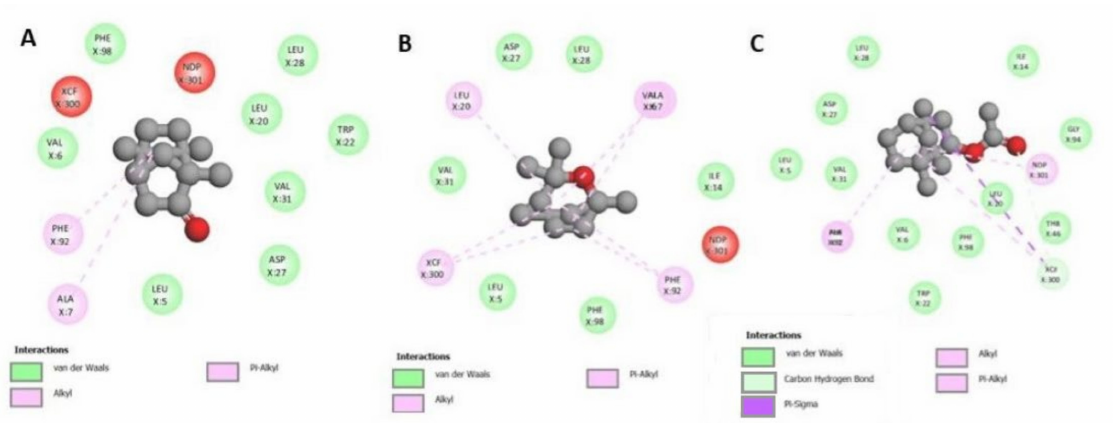
Figure 8. The interaction between dihydrofolate reductase (DHFR) and tested compounds. ( A ): Beta- terpineol; ( B ): Terpinen-4-ol ( C ):